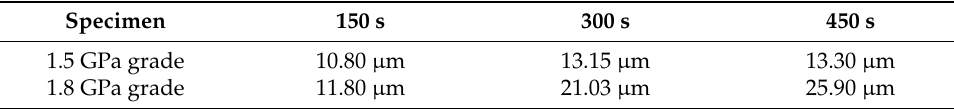
Table 5. Variations of prior austenite grain size as a function of austenitizing time at 1203 K in 1.5 GPa grade and 1.8 GPa grade steels.